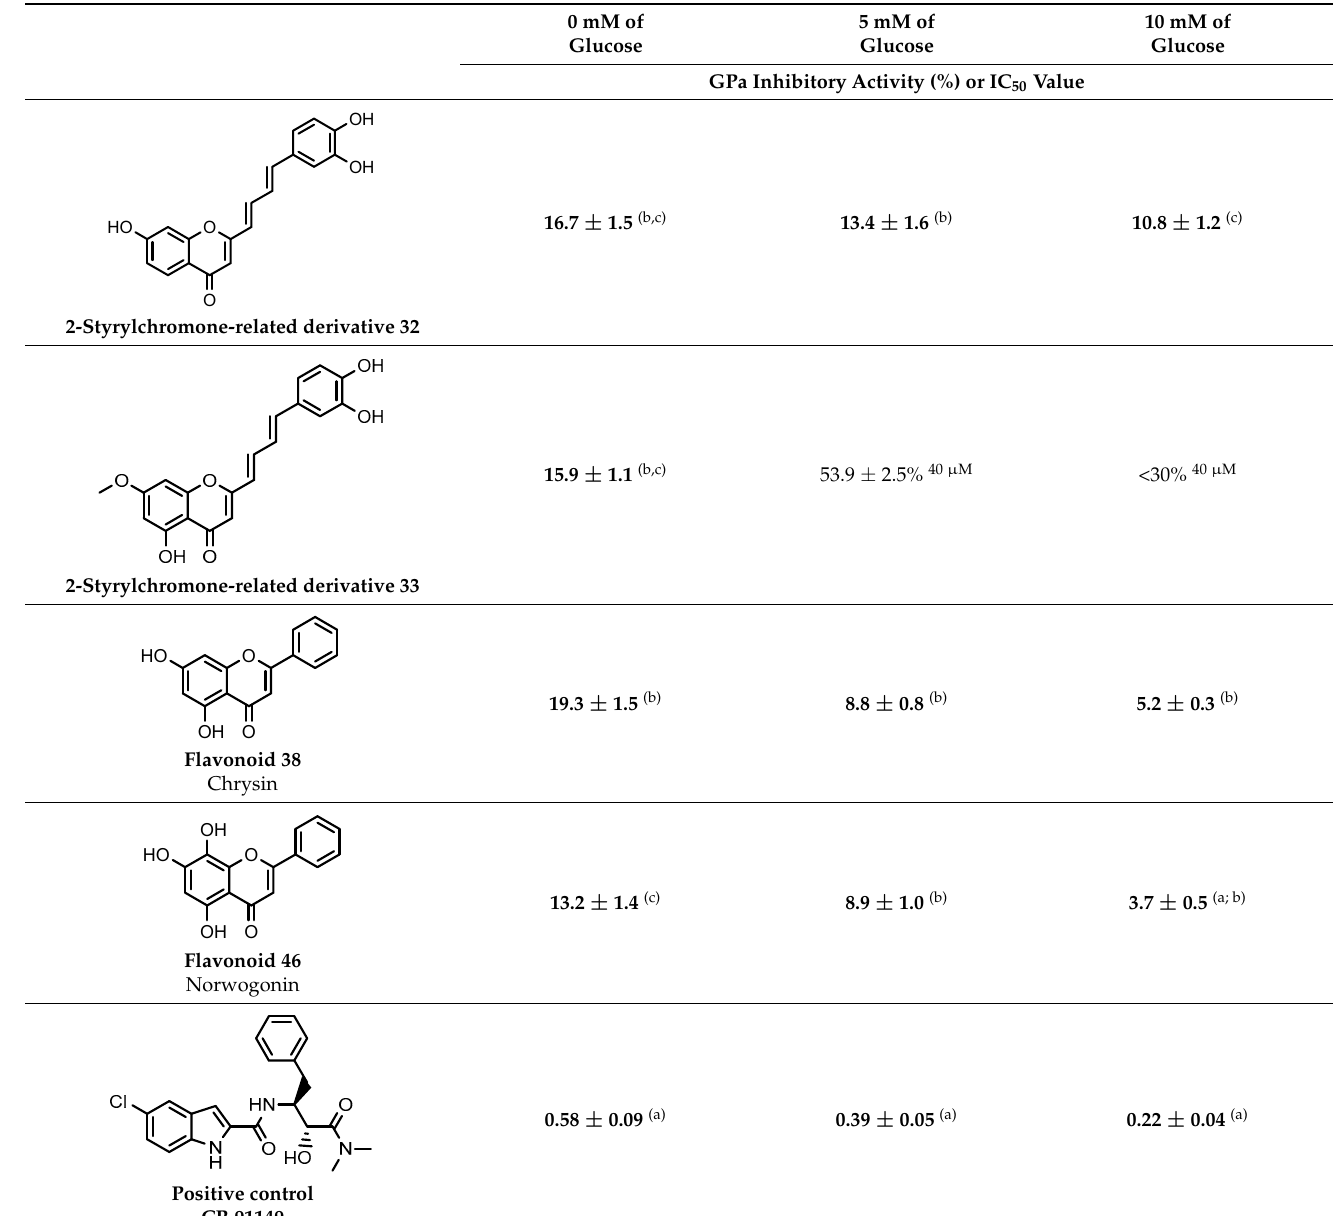
Table 2. Chemical structures and in vitro inhibitory activities of compounds 32 , 33 , 38 , 46 , and the positive control, CP-91149 , against GPa activity, with 0 mM, 5 mM, and 10 mM of glucose concentrations.